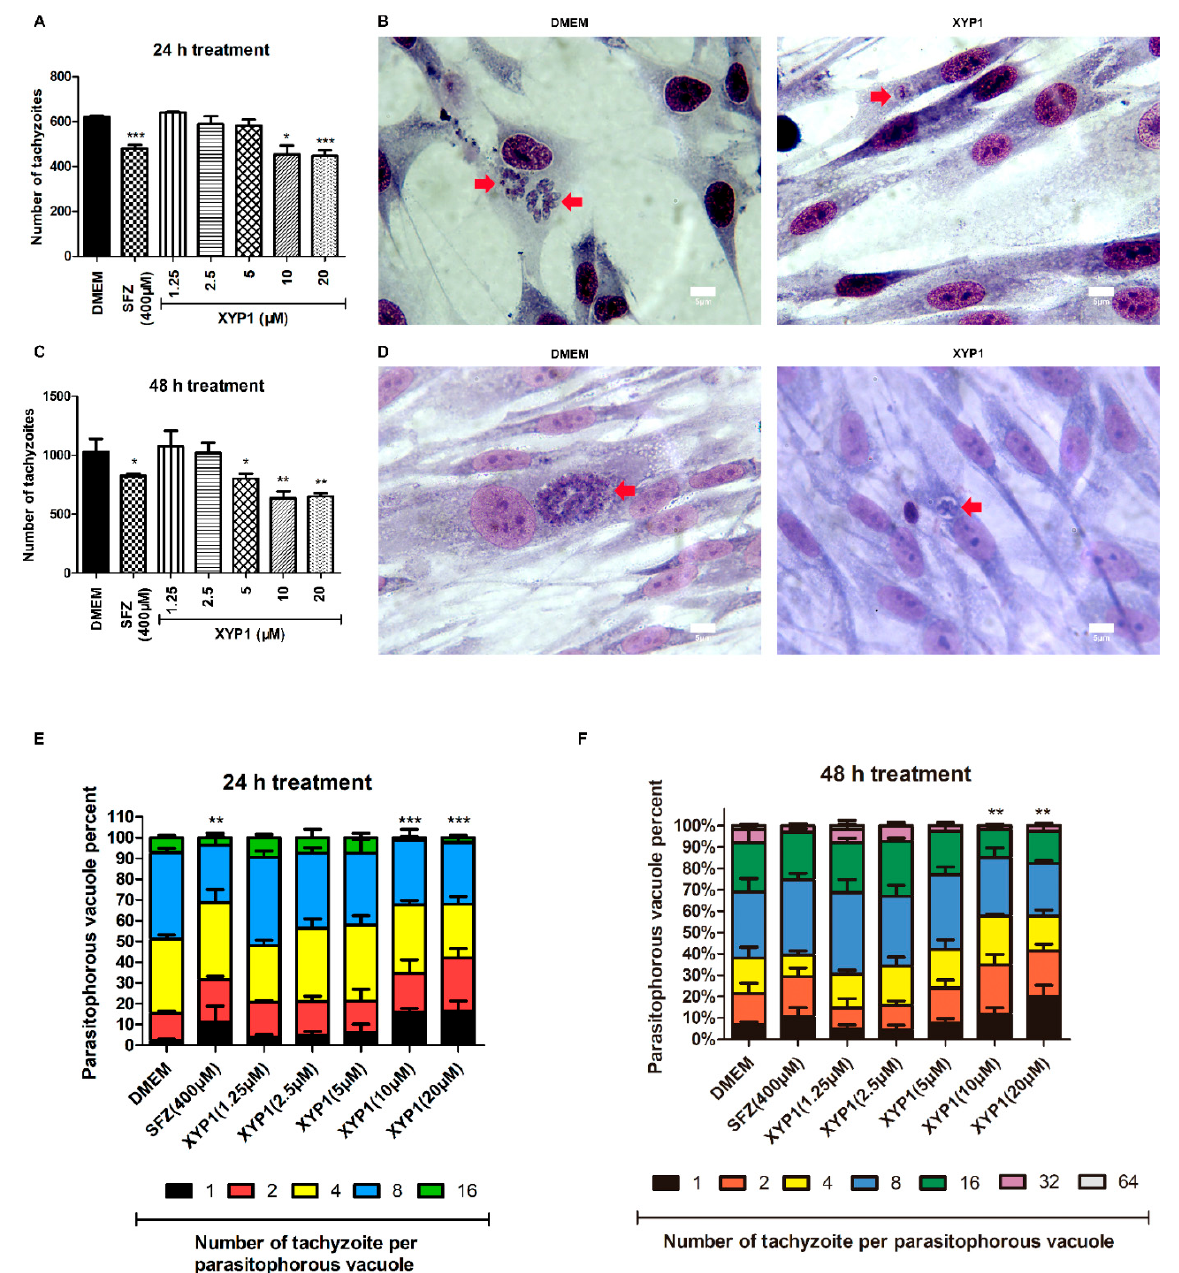
Figure 4. Effects of XYP1 on the proliferation of T. gondii tachyzoites. HFFs were infected with tachyzoites and treated with two-fold serial dilutions of XYP1 and SFZ for 24 ( A ) or 48 h ( C ) to evaluate their effects on the tachyzoite proliferation. Infected cells were incubated with DMEM or XYP1 for 24 h ( B ) or 48 h ( D ), and then observed by the light microscope. The number of tachyzoites per PV was also calculated to evaluate their anti-tachyzoite effects ( E , F ). The means were determined by values obtained from three independent experiments. * p < 0.05, ** p < 0.01 and *** p < 0.001 in comparison with negative control. Scale bars = 5 µ m.